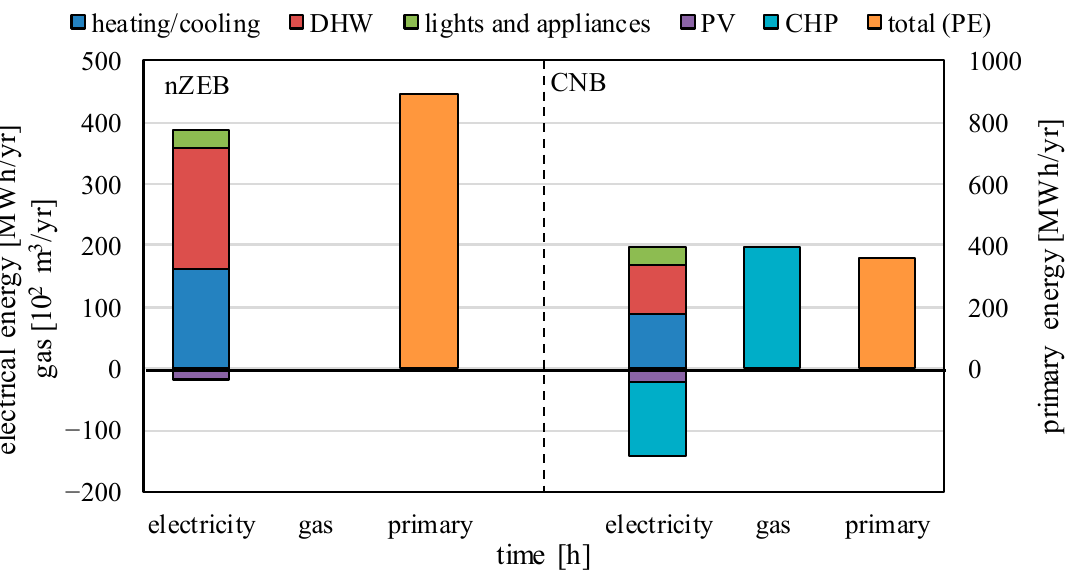
Figure 9. Overall consumption and production.